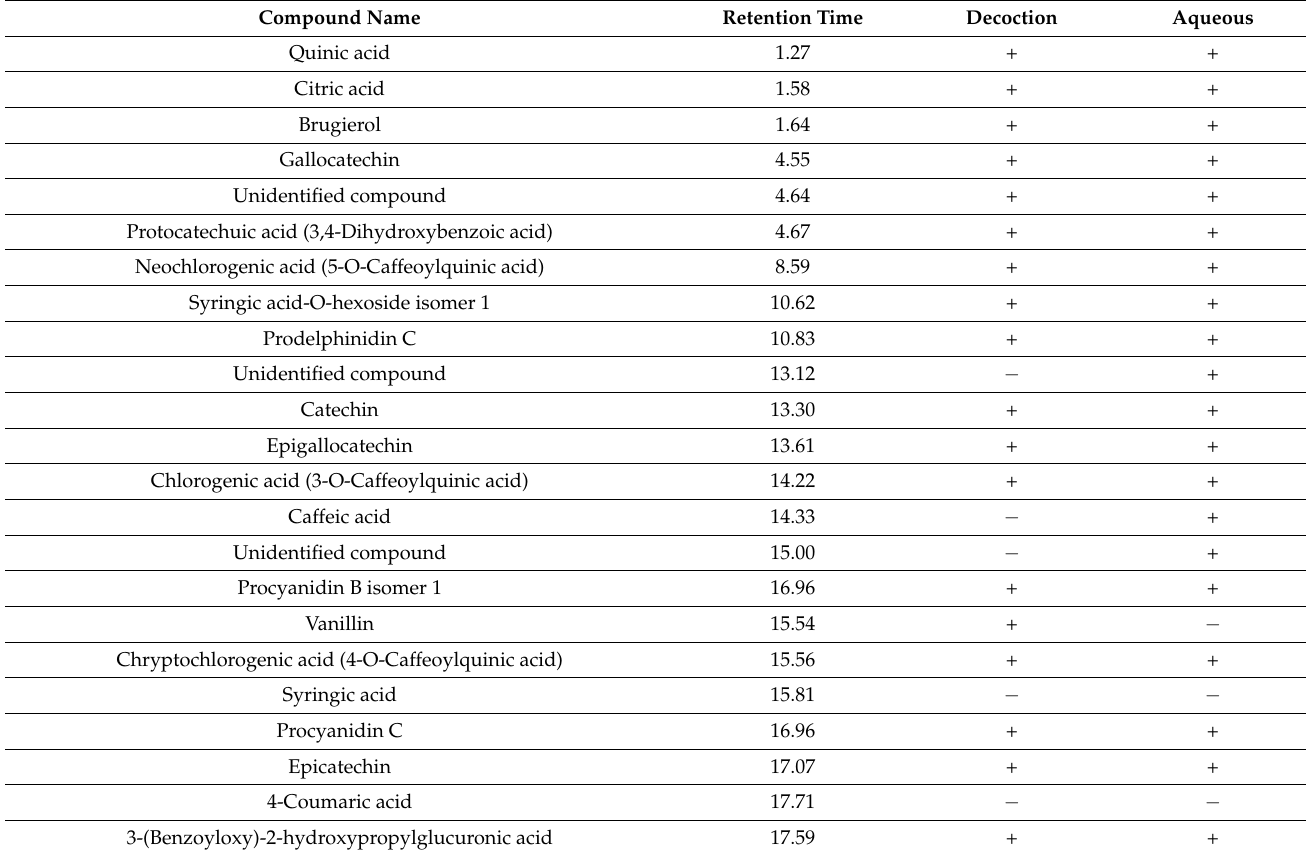
Table 4. Chemical composition of root